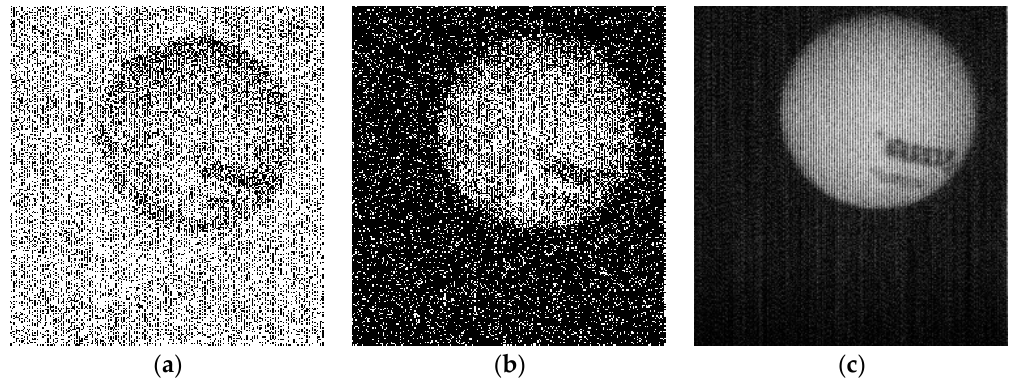
Figure 9. Results of time-gated imaging of fast-falling ( ≈ 10 m/s) table tennis ball, in terms of consecutive bit-plane exposures (global shutter, 100 µs), obtained using ( a ) a long time gate; ( b ) a short time gate; and ( c ) an image of the tennis ball as reconstructed from 32 short gate bit-planes through the application of the tracking scheme. A Nikon f/1.4 50 mm objective was used.